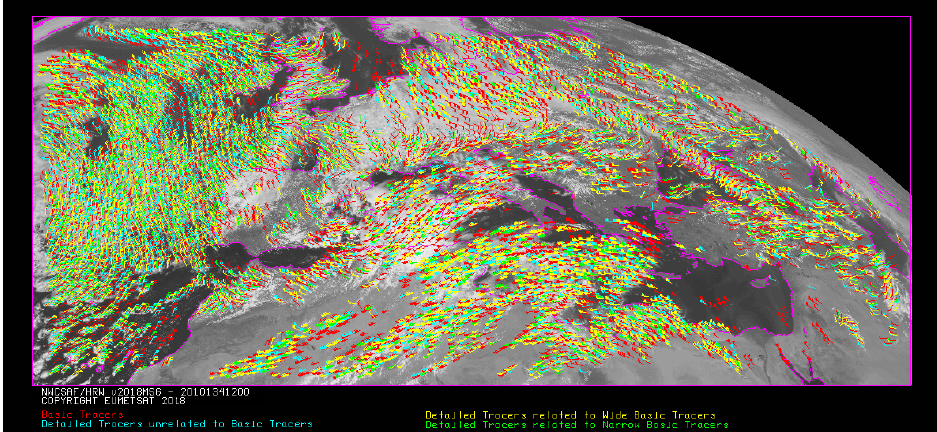
Figure 3. ‘Basic scale AMVs’ (in red and green, related to the tracer calculation method used for their extraction), in a single scale NWC/GEO-HRW example for the European and Mediterranean region, with the default conditions for MSG satellites (14 May 2010, 12:00 UTC, MSG-2 satellite).